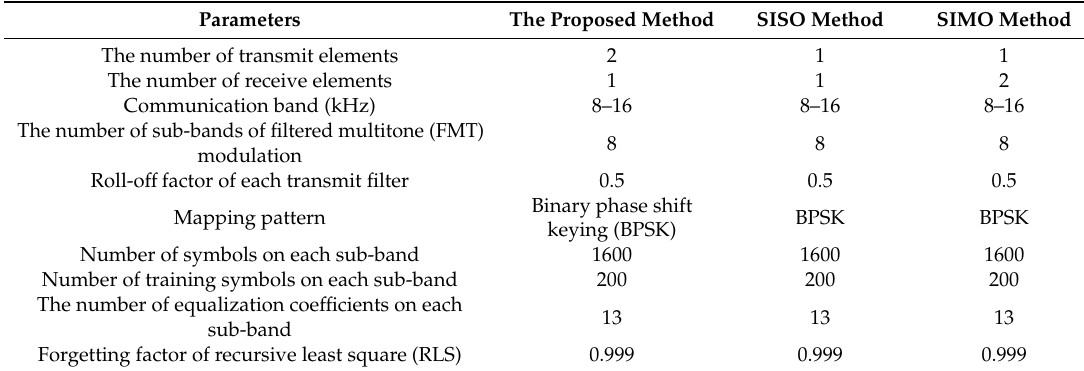
Table 1. Parameters for simulation